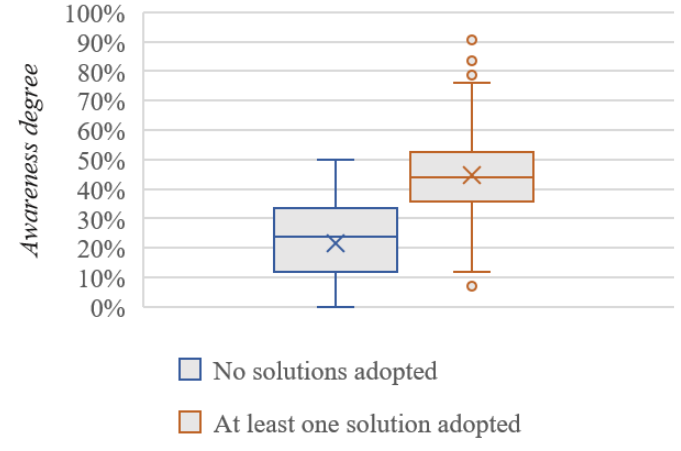
Figure 6. Boxplot graph of awareness level and utilization of 4.0 solutions.